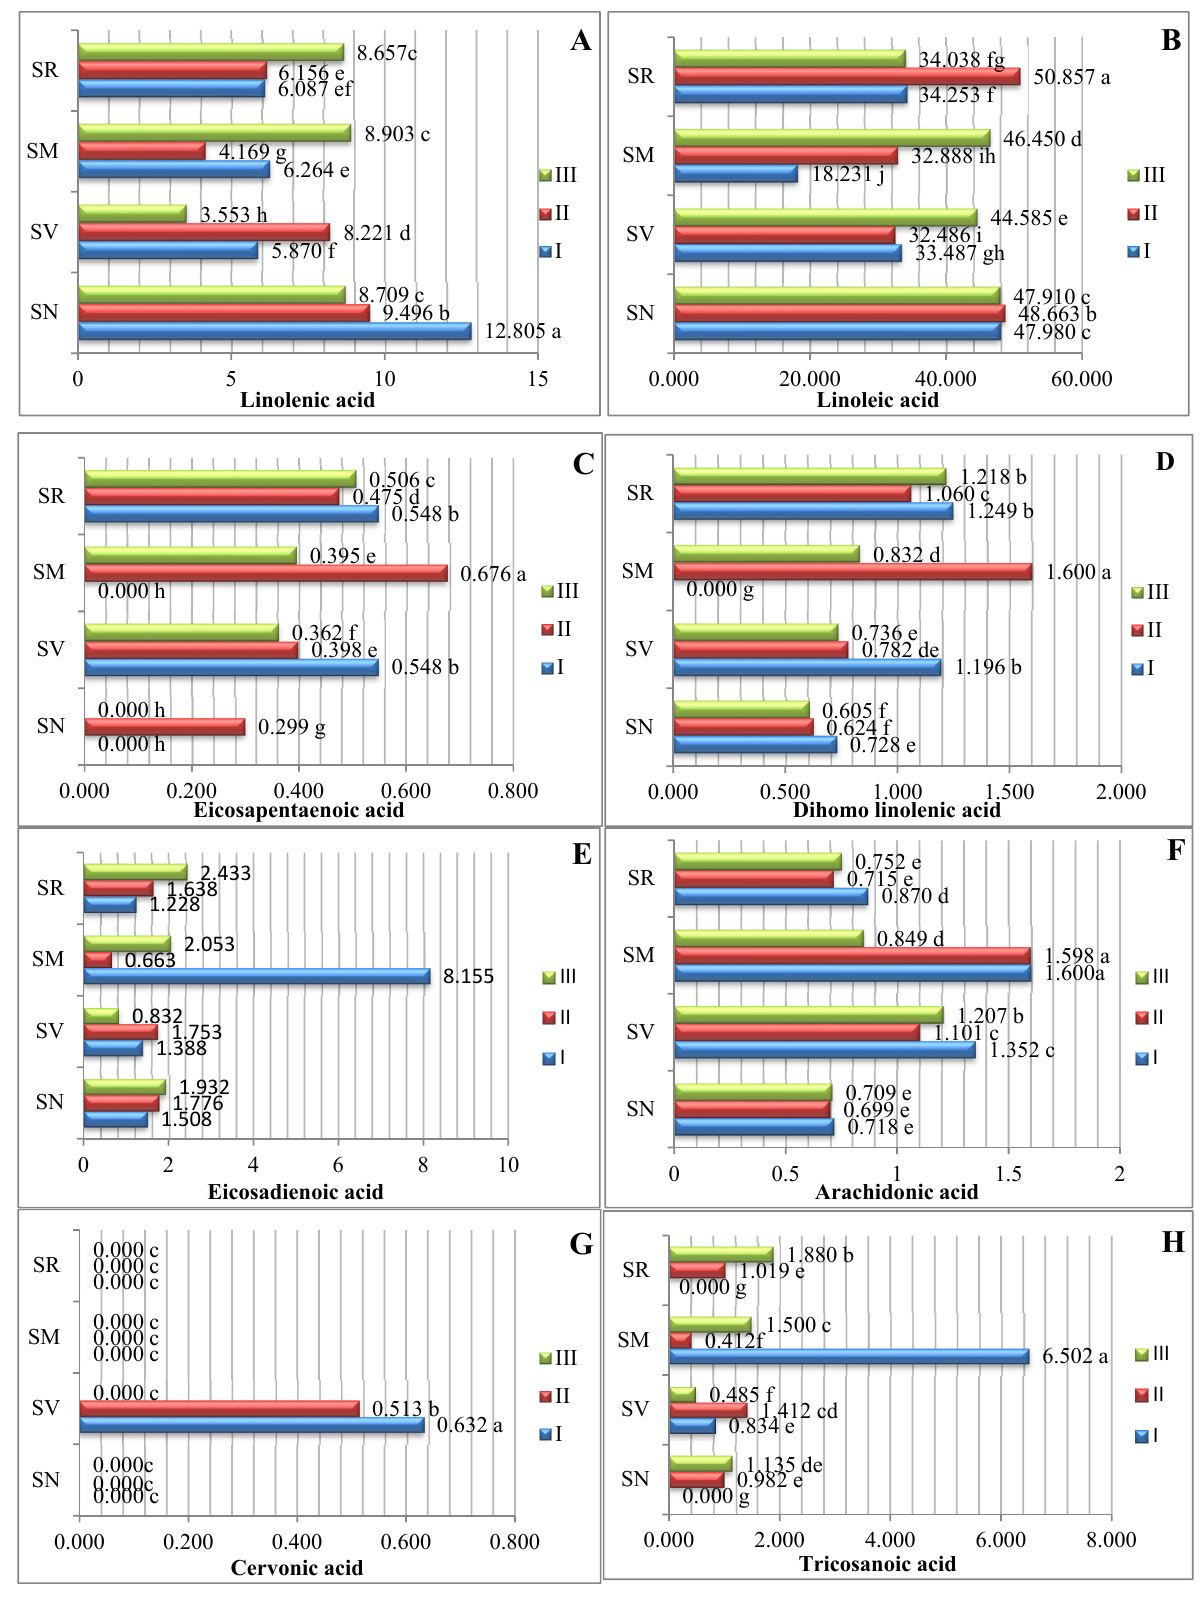
Figure 3. Amounts of polyunsaturated fatty acids in Solanum spp. fruit, %, in different ripening stages. Note: Percentages followed by different letters are statistically different ( p < 0.05); S. retroflexum –(SR), S. melanocerasum –(SM ) , S. nigrum –(SN), S. villosum –(SV); ripening stages I, II, III. Linoleic, linolenic, and arachidonic acids show starkly different patterns of accumu-